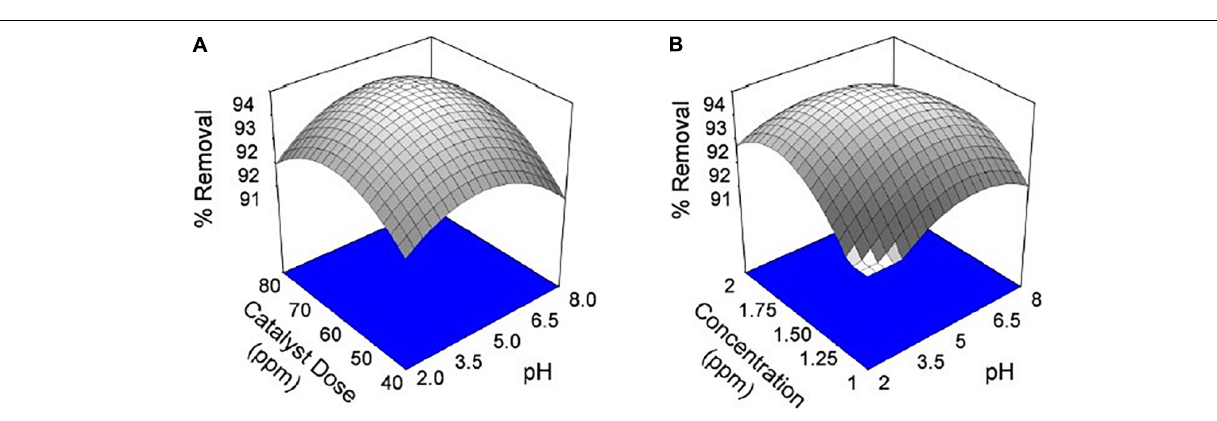
carbon (Yao et al., 2014), bio-char (Idrees et al., 2018), bio- char (Idrees et al., 2018), and seed (Aregawi and Mengistie, 2013). It assumes the extent of non-linearity among solution